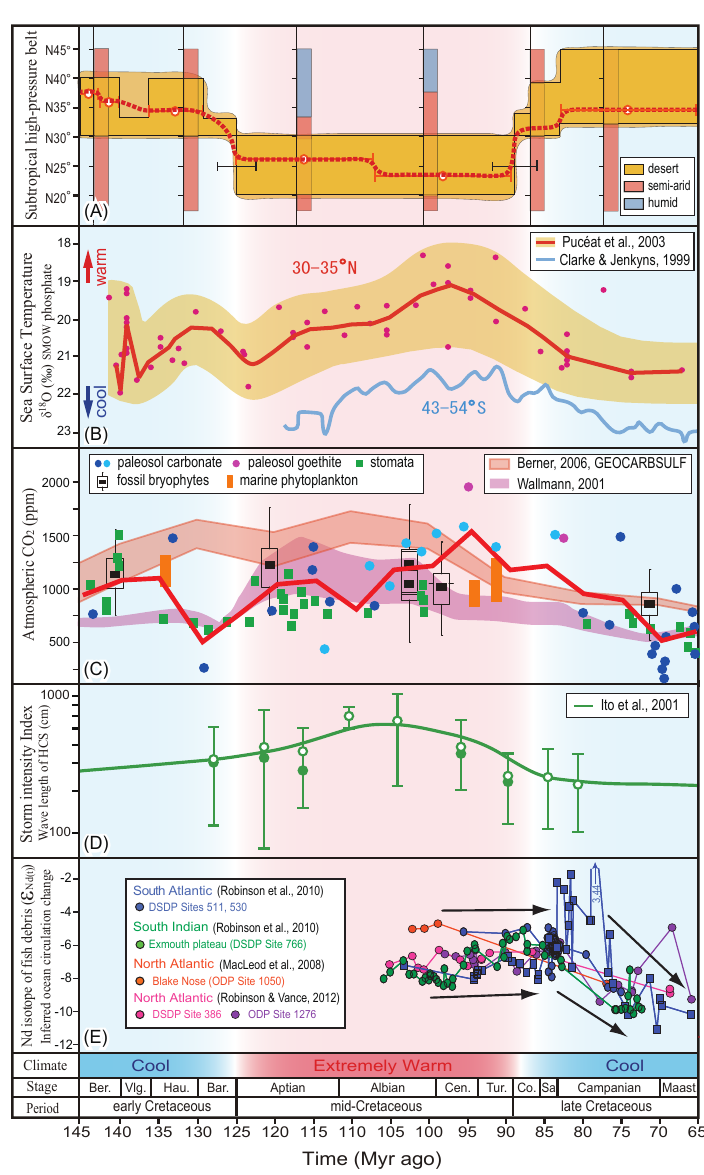
Fig. 4. (A) Reconstructed latitudinal distribution of the subtropical high-pressure belt in Asia (this study). Orange areas represent the latitudinal distribution of desert deposits (sense, Fig. 1), and the red dotted line shows the inferred divergence axis of the subtropical high-pressure belt. Estimation errors of the depositional ages of the formations are indicated as error bars. (B) Sea surface temperature at 30–35 ◦ N estimated from the oxygen isotope record of fish-tooth phosphates (Puc´eat et al., 2003) and at 43–54 ◦ N estimated from the oxygen isotope record of bulk shallow-marine carbonates (Clarke and Jenkyns, 1999). (C) Atmospheric CO 2 levels are based on estimates derived from proxy records (modified after, compilation of paleosol carbonate (blue), paleosol goethite (purple), and stomata (green) by Breecker et al. (2010); and additional evidence: fossil bryophytes (black; Fletcher et al., 2008), marine phytoplankton (orange; Freeman and Hayes, 1992; Royer et al., 2001), and paleosol carbonate (light blue; Hong and Lee, 2012)) and carbon cycle model estimates (Wallmann, 2001; Berner, 2006, GEOCARBSULF). Five million year means of the proxy-based estimates are shown by the red line. These limited datasets of the atmospheric CO 2 estimates suggest slightly higher atmospheric CO 2 value (ca. 1000–1500ppm) during the extremely warm mid-Cretaceous “supergreenhouse” period, compared to the slightly lower value (ca. 500–1000ppm) during the late Cretaceous period. (D) Variations in storm intensity estimated based on the wavelength of hummocky cross-stratification (HCS) (Ito et al., 2001). Vertical bars indicate ranges in wavelength, and open and filled circles represent the mid-point wavelength and average wavelength, respectively. The solid line represents a two-point moving average of mid-point values (Ito et al., 2001). (E) Variations in Nd-isotope data from the Cretaceous intermediate- to deep-water masses (modified afterRobinsonetal.,2010;MacLeodetal.,2011;RobinsonandVance,2012).NorthAtlanticODPSite1050data(orangecircle)arefromMacLeodetal.(2008).NorthAtlanticdata from DSDP Site 386 (pink circle) and ODP Site 1276 (purple circle) are from Robinson and Vance, 2012. South Atlantic (blue circle and square) and southern Indian data (red closed circle) are from Robinson et al. (2010). The Nd-isotopic variations in several oceans demonstrated consistently higher Nd-isotope values ( − 8 to − 4) during the mid-Cretaceous (Albian to Coniasian–Santonian), whereas the values became gradually lower ( − 12 to − 8) during the late Cretaceous (Campanian–Maastrichtian), suggesting an intensification of deep ocean circulation in high-latitude oceans (especially at southern high-latitudes) during the late Cretaceous (Robinson et al., 2010; MacLeod et al., 2011; Robinson and Vance, 2012). (F) Inferred climate mode of the early, mid- and late Cretaceous. The mid-Cretaceous is characterized by an extremely warm “supergreenhouse” mode, while the early and late Cretaceous are characterized by a relatively cooler, but still moderately warm “greenhouse”